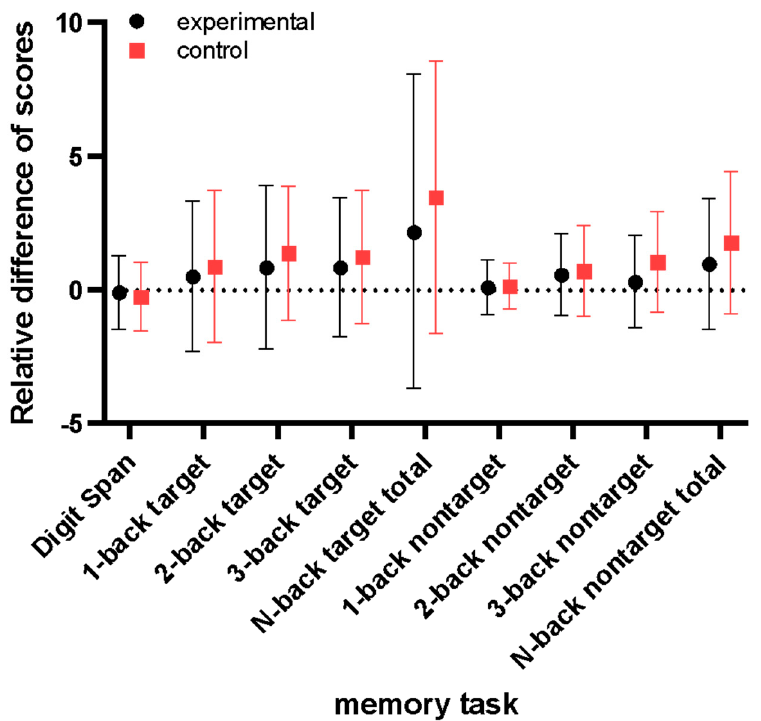
Figure 8. Relative difference of task score for experimental and control stimulation condition.